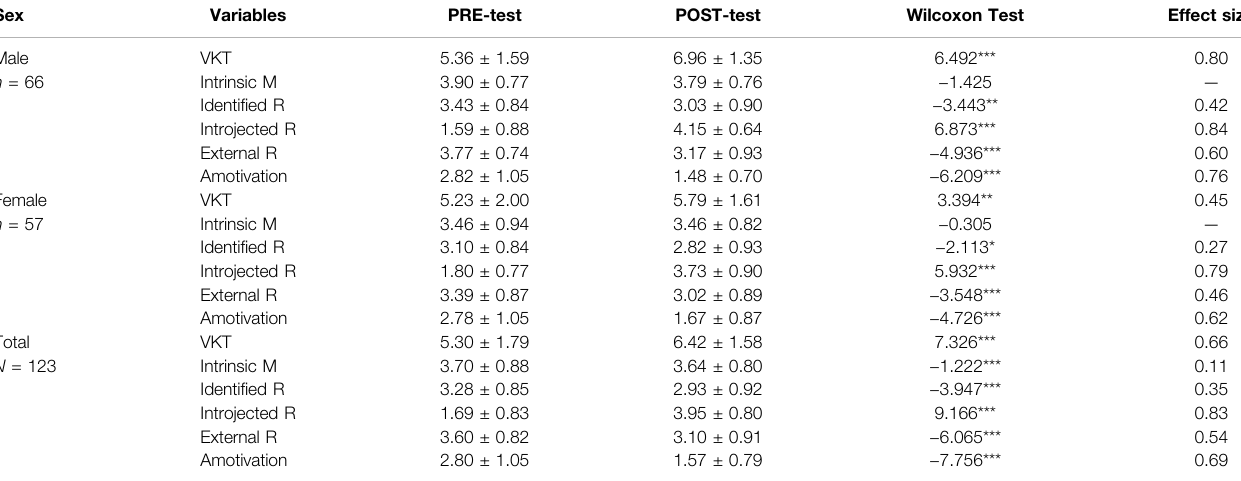
TABLE 6 | Comparing variables intra-group (pre vs post) using Wilcoxon test according to sex in control group (Av ±